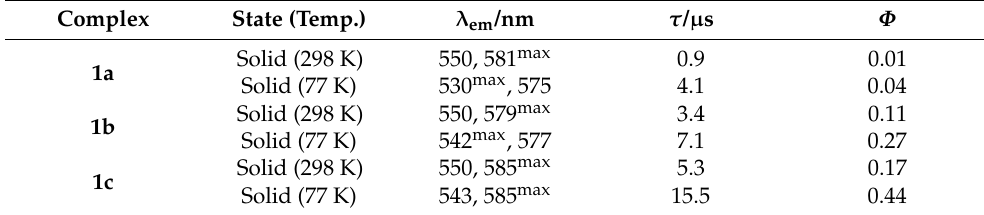
Table 2. Emission data for 1a – c a